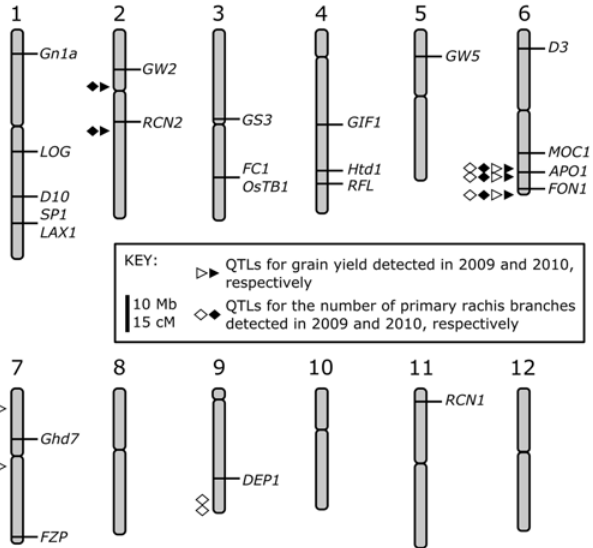
Fig 3. A genetic linkage map showing the positions of QTLs for grain yield and for the number of primary rachis branches on rice chromosomes in 2009 and 2010. The map is adapted from [43]. Genes known to affect grain yield in rice are indicated on the right of each